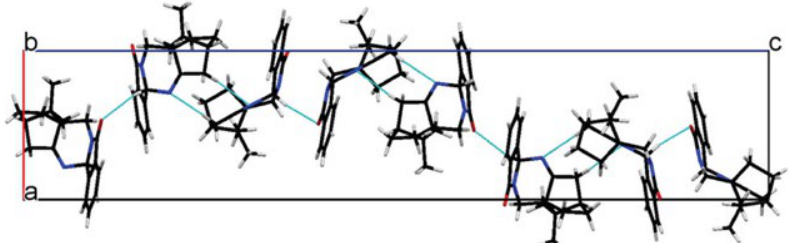
Figure 6. Mercury 29 drawing of molecular packing in 7 . Light blue lines show weak intermolecular C-H…O and C-H…N hydrogen bonds.